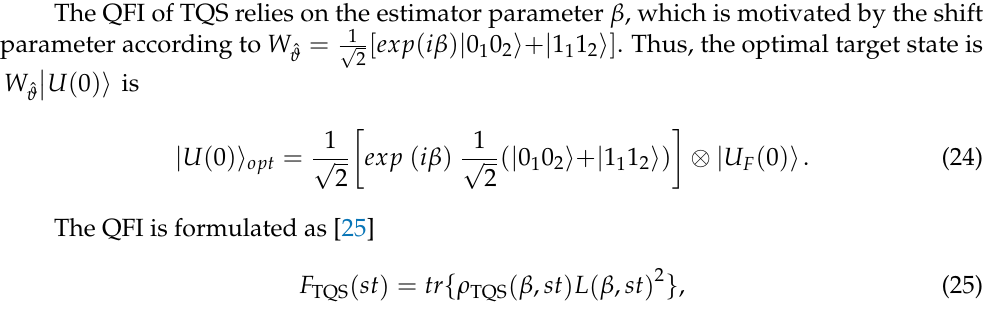
Figure 4. Time evolution of the TQS entanglement denoted by C 12 when the TQS state is initially defined in a fully separable state, 𝜃 = 0. Panels ( a , b ) correspond to the case of absence of the PDP effect (i.e., 𝜆 = 0) for constant (𝐷(t) = s) and t-dc ( 𝐷(t) = s sin(t)) , respectively. Panels ( c , d ) are, respectively, the same as ( a , b ) but in the presence of the PDP effect with 𝜆 = 50 .